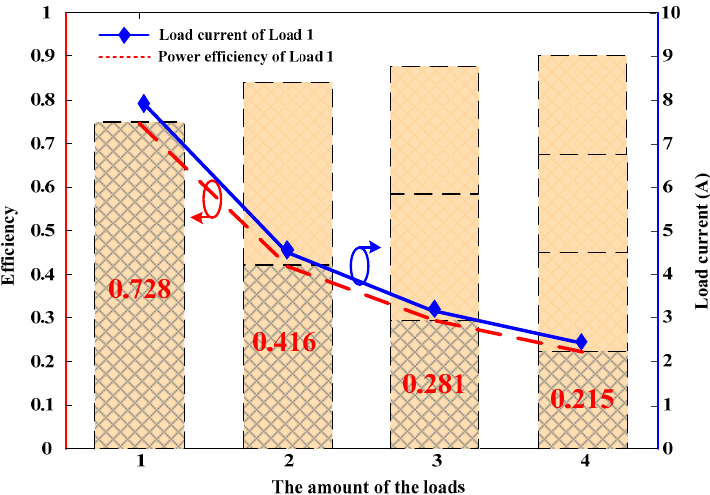
Figure 8. The change in the load current and system efficiency with the number of loads in the system based on S–S topology.